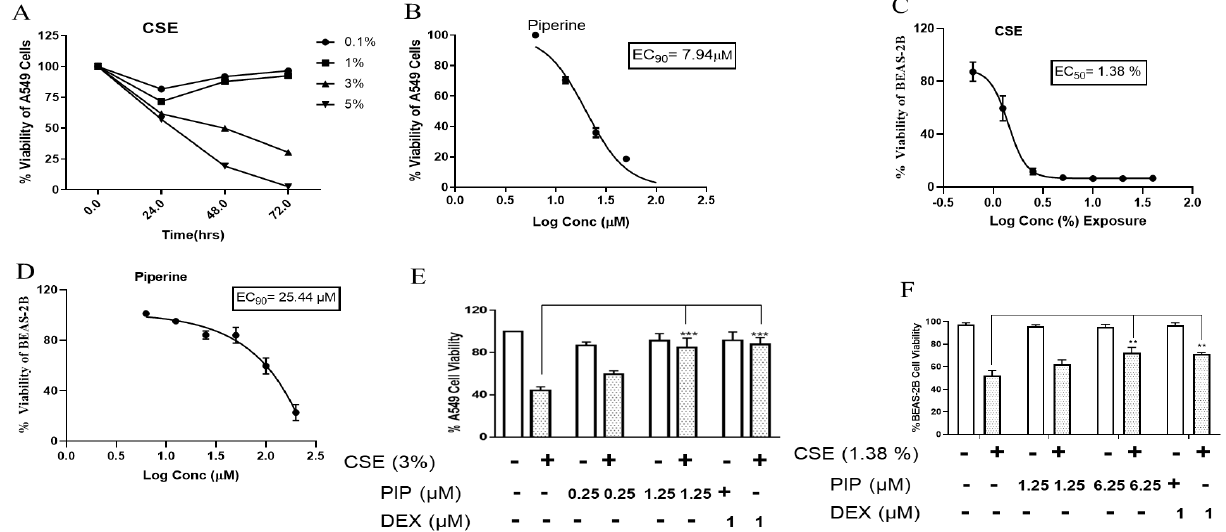
Figure 1. Cytotoxicity assessment of cigarette smoke and piperine by using MTT assay: ( A ) Dose- dependent cytotoxicity of cigarette smoke over the exposure of cigarette smoke at three different time points (24, 48, and 72 h) in A549 cells. ( B ) Represents % viability of A549 cell line exposed to different concentrations of PIP (0, 1.56, 3.12, 6.25, 12.5, 25, 50, and 100 µM). ( C ) Dose-dependent cytotoxicity was observed during the exposure of cigarette smoke at 48 h in BEAS-2B cells. ( D ) Represents % viability of BEAS-2B cell line exposed to different concentrations of piperine (0–200 µM). ( E ) Piperine treatment protects the CSE-induced cell death in A549 cells. ( F ) Piperine treatment protects the CSE-induced cell death in BEAS-2B cells. Values are expressed as mean ± SEM of triplicate experiment. *** p < 0.001, ** p < 0.01 vs. CSE exposed group. Data were analyzed using graph pad prism 7 software.